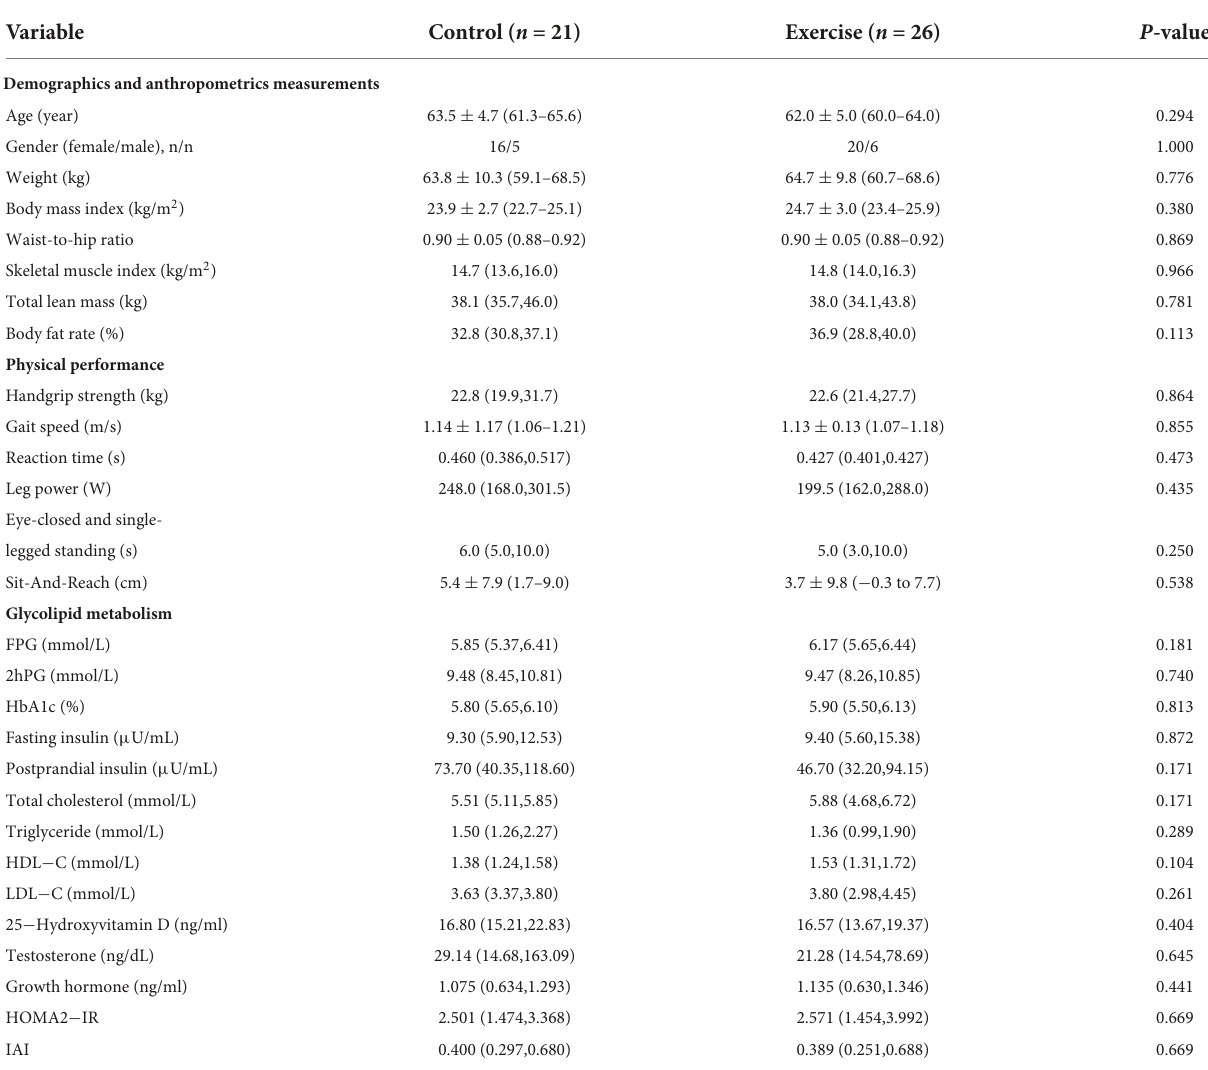
TABLE 2 Baseline characteristics of the participant in the study. Variable